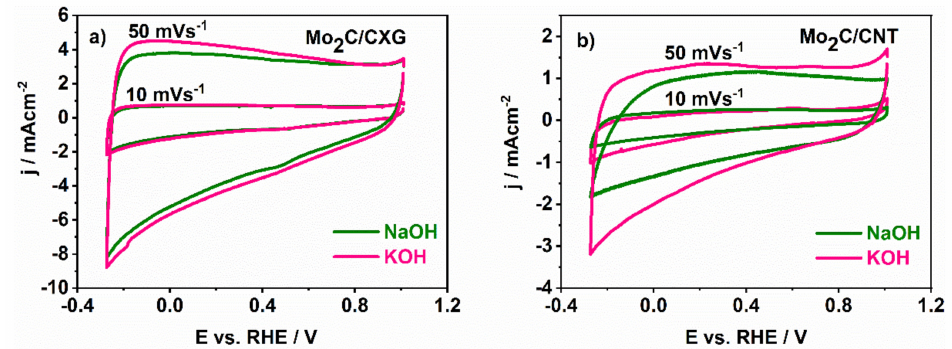
Figure 2. Cyclic voltammograms of ( a ) Mo 2 C / CXG and ( b ) Mo 2 C / CNT in KOH and NaOH aqueous electrolytic solution at scan rates of 10 mV s − 1 and 50 mV s − 1 .